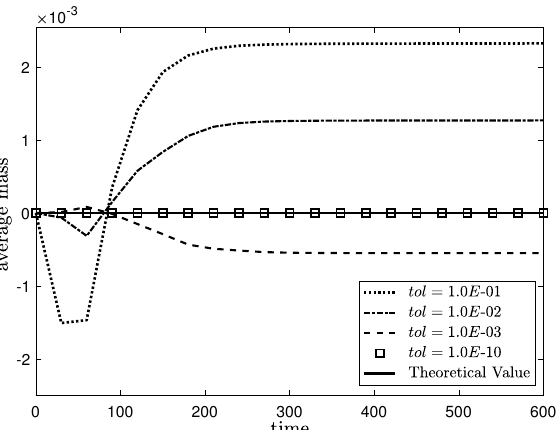
h ( φ n ) / ( h 2 N Figure 7. Average mass x N y ) of the numerical solutions in various values of tolerance. M Here, the theoretical value (solid line), tol = 1.0 10 − 1 (dotted line), tol = 1.0 × = 1.0 10 − 3 (dashed line) and tol = 1.0 10 − 10 (square). × ×